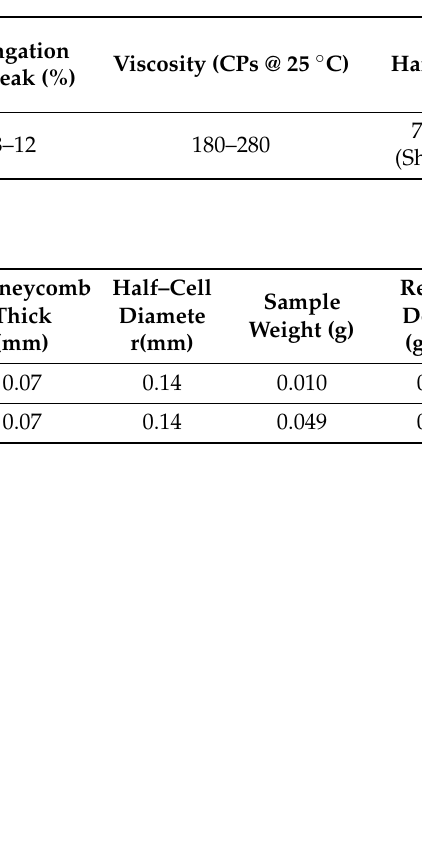
Table 1. The parameters of resin material provided by manufacturers.